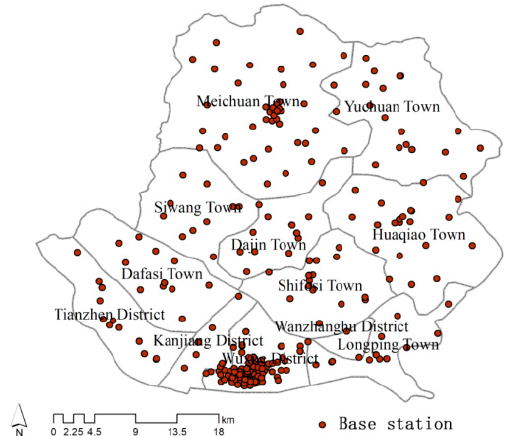
Figure 3. Base station distribution map.